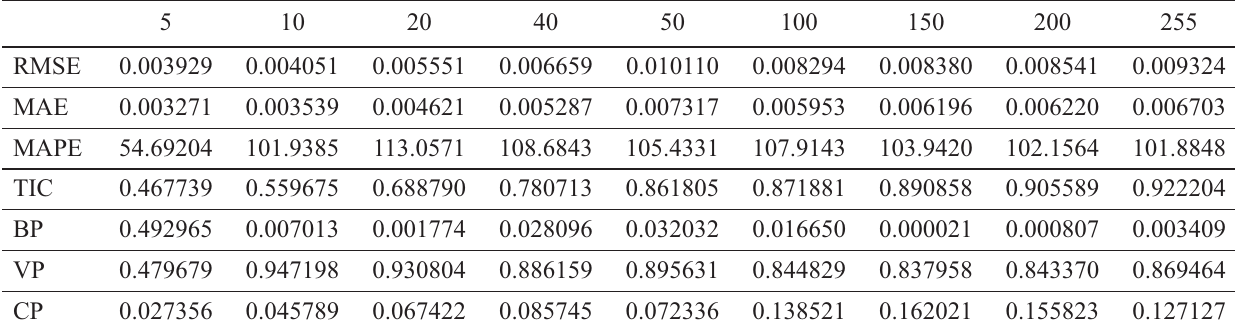
Table 3. A relationship between forecast measures and time